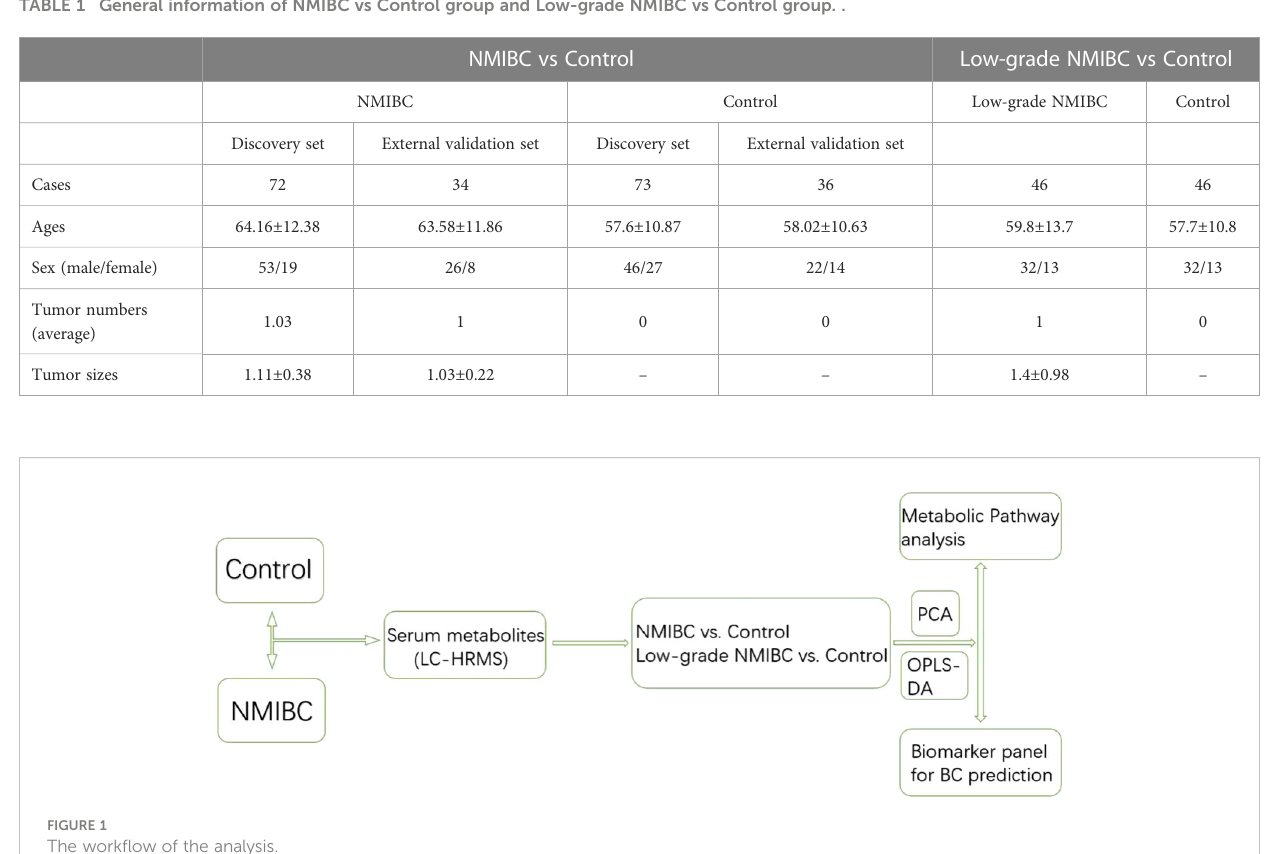
TABLE 1 General information of NMIBC vs Control group and Low-grade NMIBC vs Control group. .